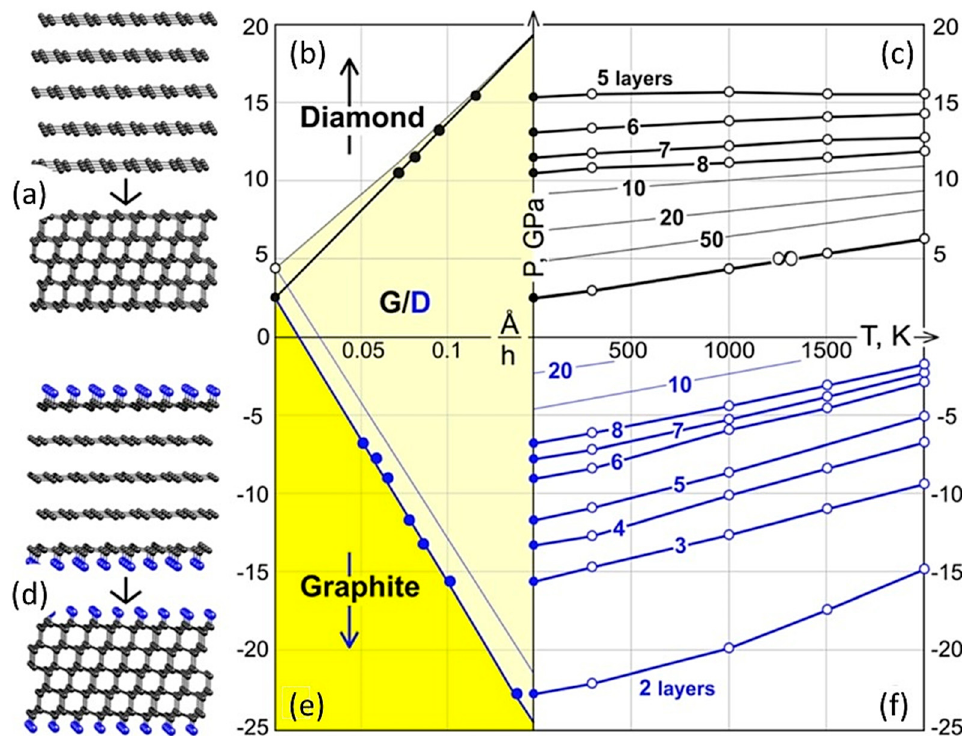
Figure 8. ( a ) Atomic structures of a five-layer graphene and the corresponding diamond film with a pristine surface. ( b ) The dependence of the phase transition pressure P on the inverse film thickness h at T = 0 and 1000 K (solid and thin lines) for films with pristine surfaces. ( c ) The phase diagram (P–T) for the different numbers of n-layer graphenes in diamanes (thin lines show equilibrium curves for n = 10, 20 and 50 layers). ( d ) Atomic structure of a five-layer graphene and the corresponding diamond film with hydrogenated surfaces. ( e ) The dependence of the phase transition pressure on the inverse film thickness h at T = 0 and 1000 K (solid and thin lines) for films with hydrogenated surfaces. ( f ) The phase diagram (P–T) for the transition from a multilayer graphene to a diamane film (H is shown in blue; thin lines show the equilibrium curves for n = 10 and 20) [35].